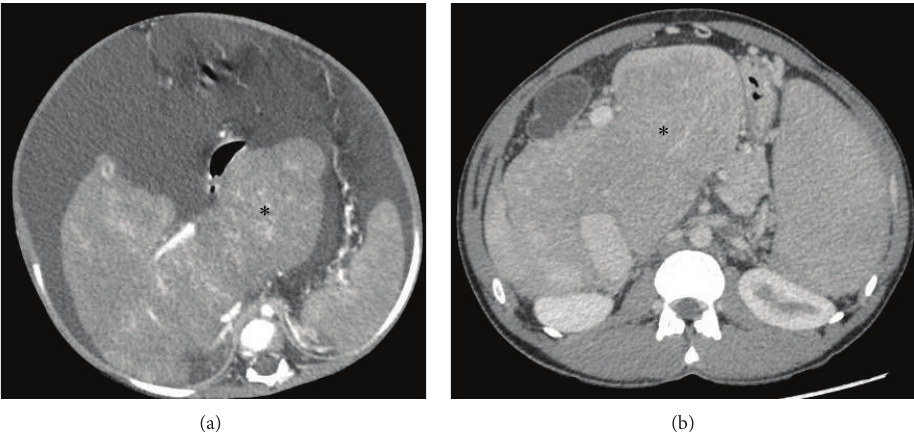
Figure 7: Axial CECT images from two different patients with chronic BCS demonstrating markedly hypertrophied caudate lobe (asterisk).